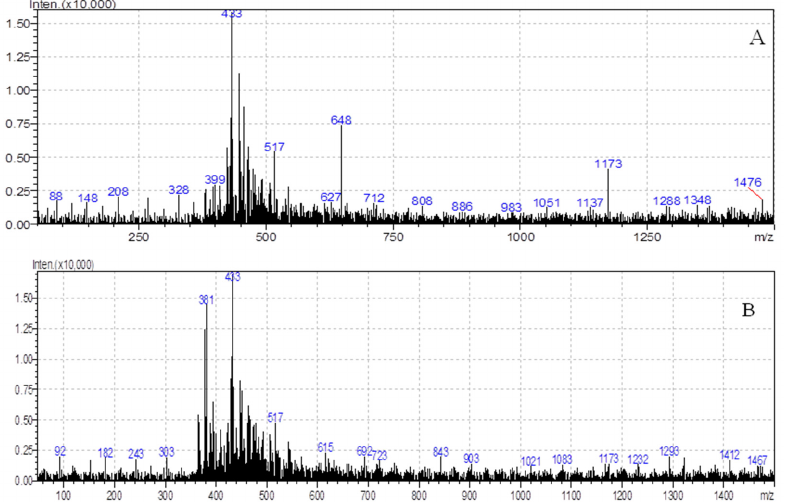
Figure 4. LC/MS analysis of aqueous phase for biodegradation process of MP-PS by ( A ) Bacillus cereus in experiment M1-24 and ( B ) Pseudomonas alcaligenes in experiment M2-23.